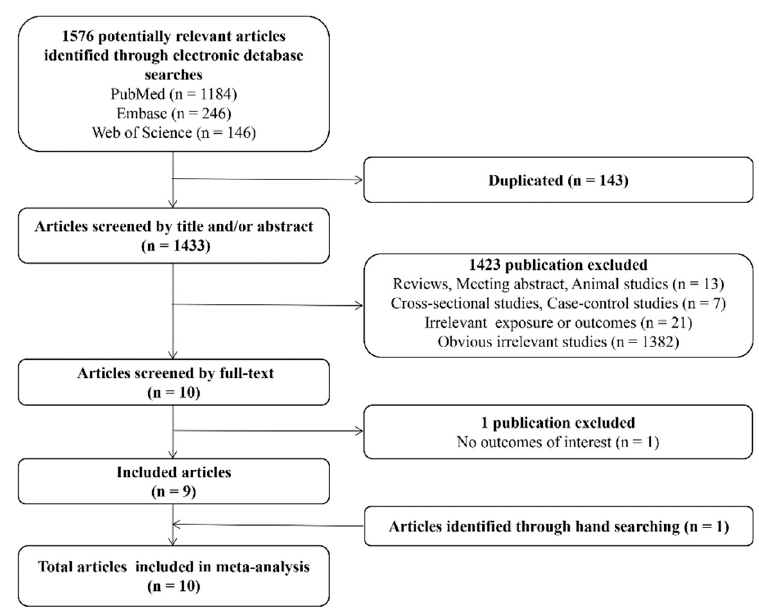
Figure 1. Flow diagram for search and selection of 10 included studies, for a meta-analysis of studies of exposure to perfluorooctanoic acid (PFOA) in early life and risk of childhood adiposity, published during 2012–2018.